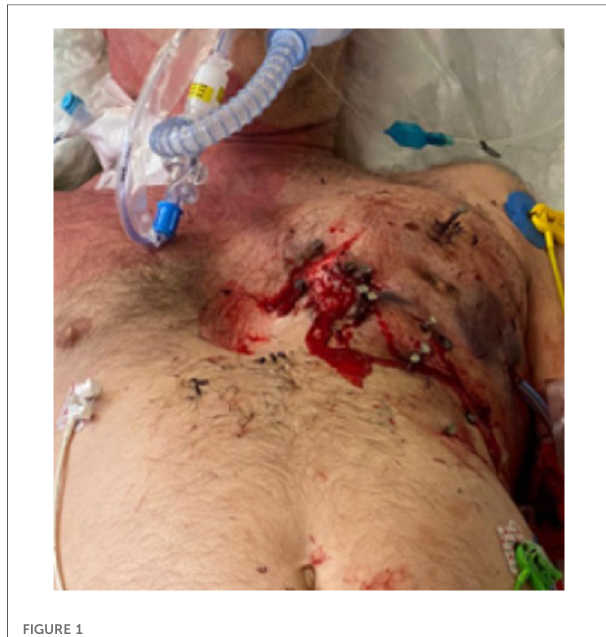
FIGURE 1 Multiple nail gunshots through the chest wall.